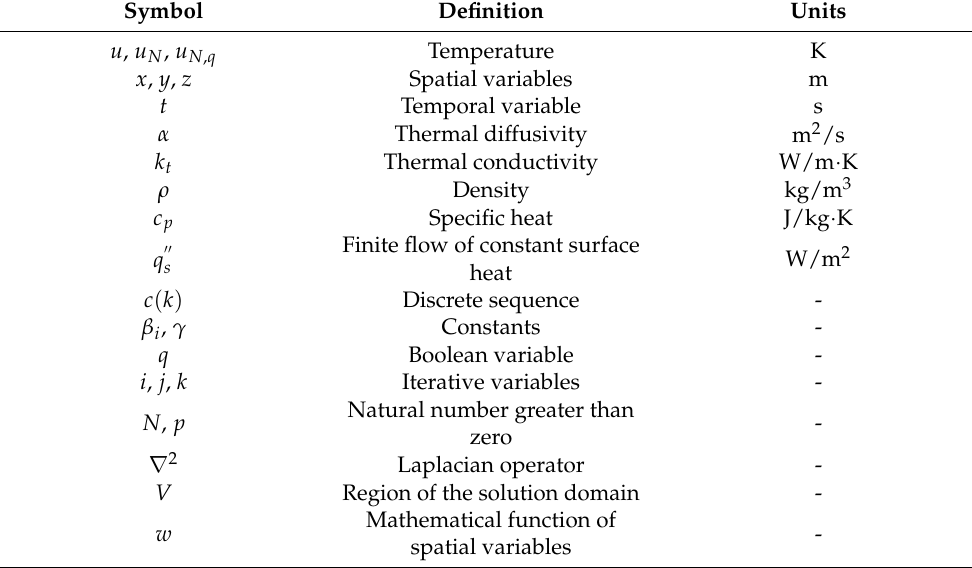
Table 1. Nomenclature used in this